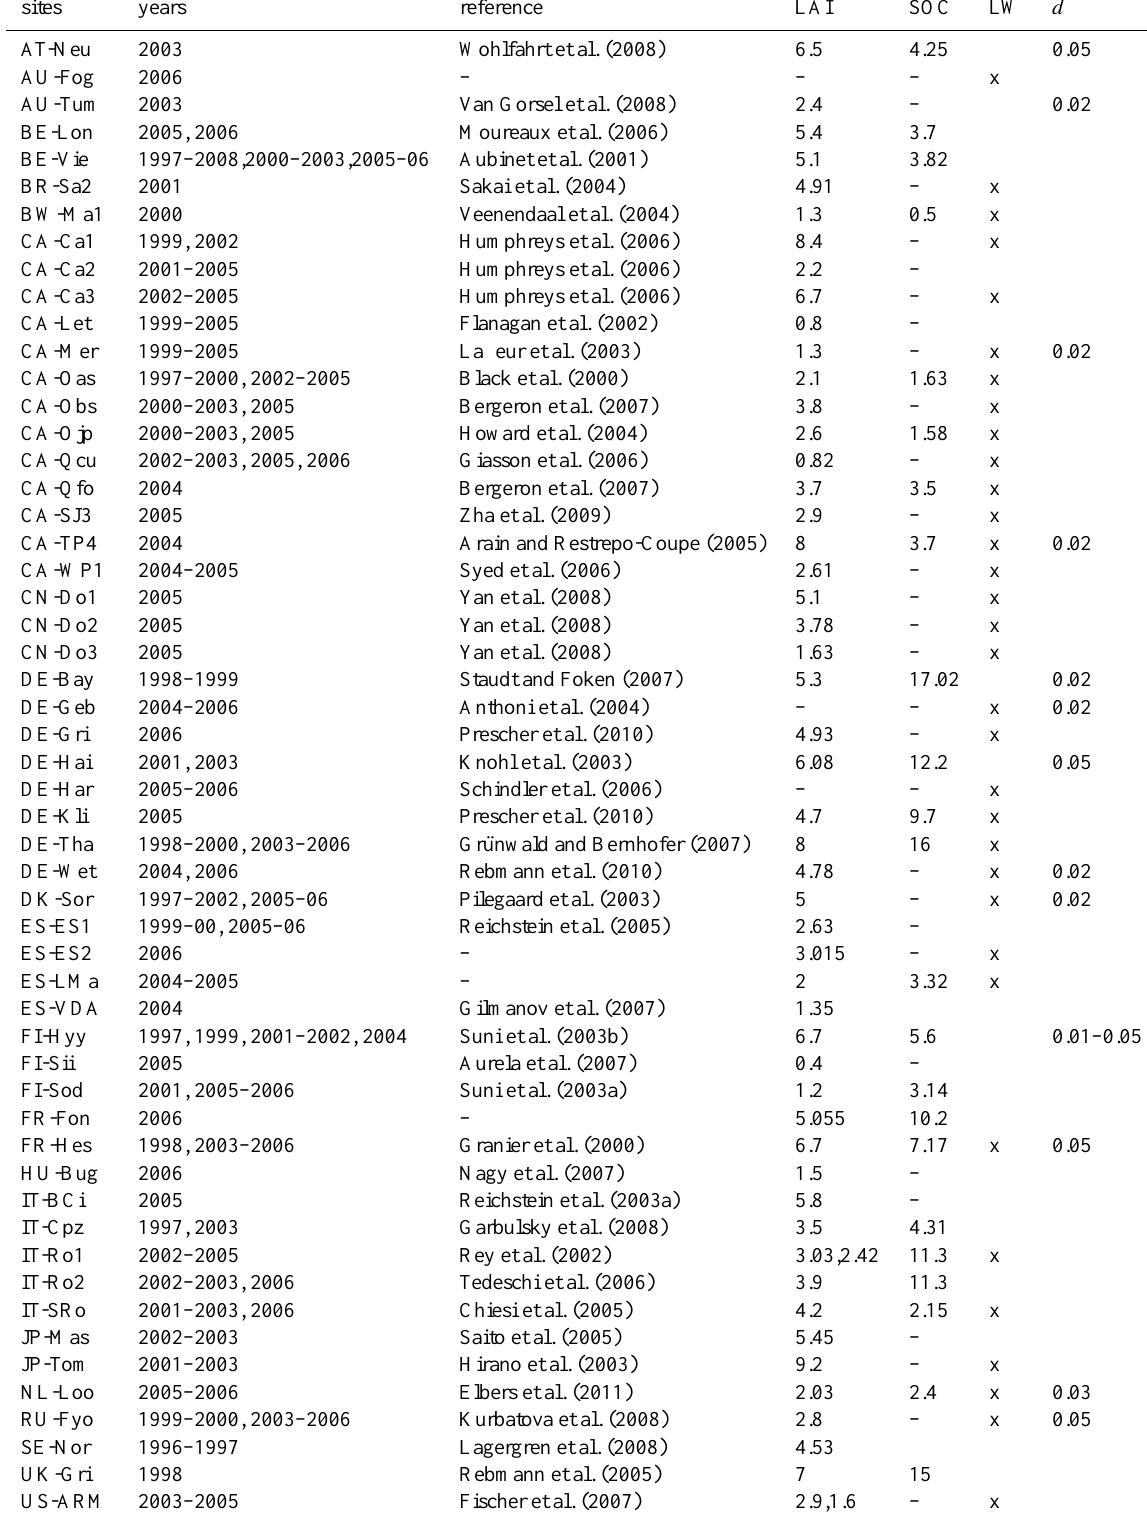
Table 1. List of FLUXNET sites and years used, reference, values of LAI and SOC included in the analysis, column LW indicates whether longwave radiation was available for the specific site and d is the measurement depth of the soil temperature in m